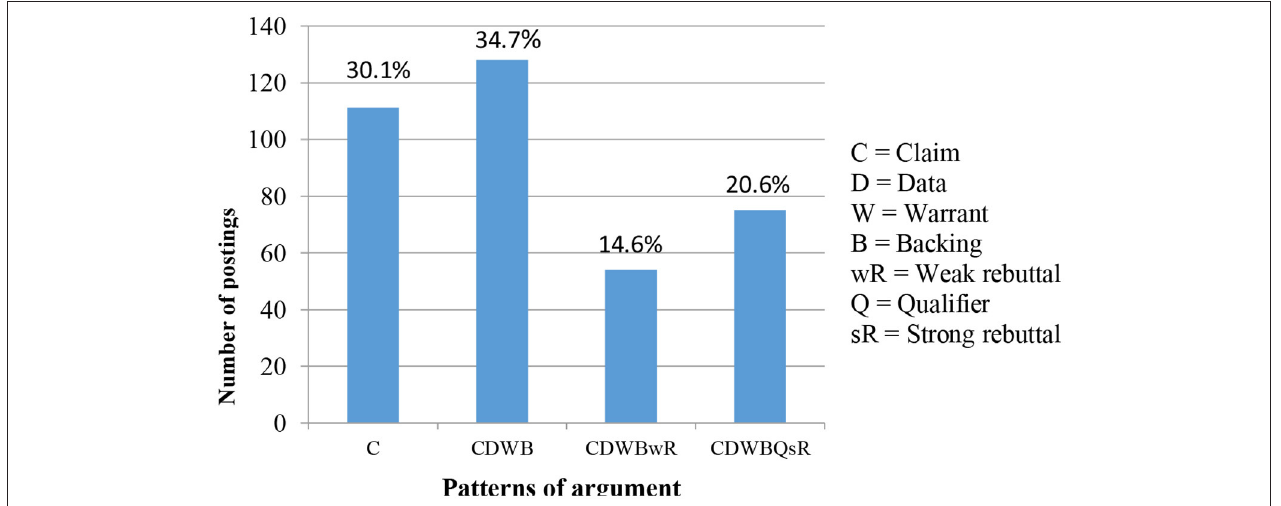
FIGURE 2 | The percentage of the argument patterns. This figure shows the percentage of the argument patterns identified in this